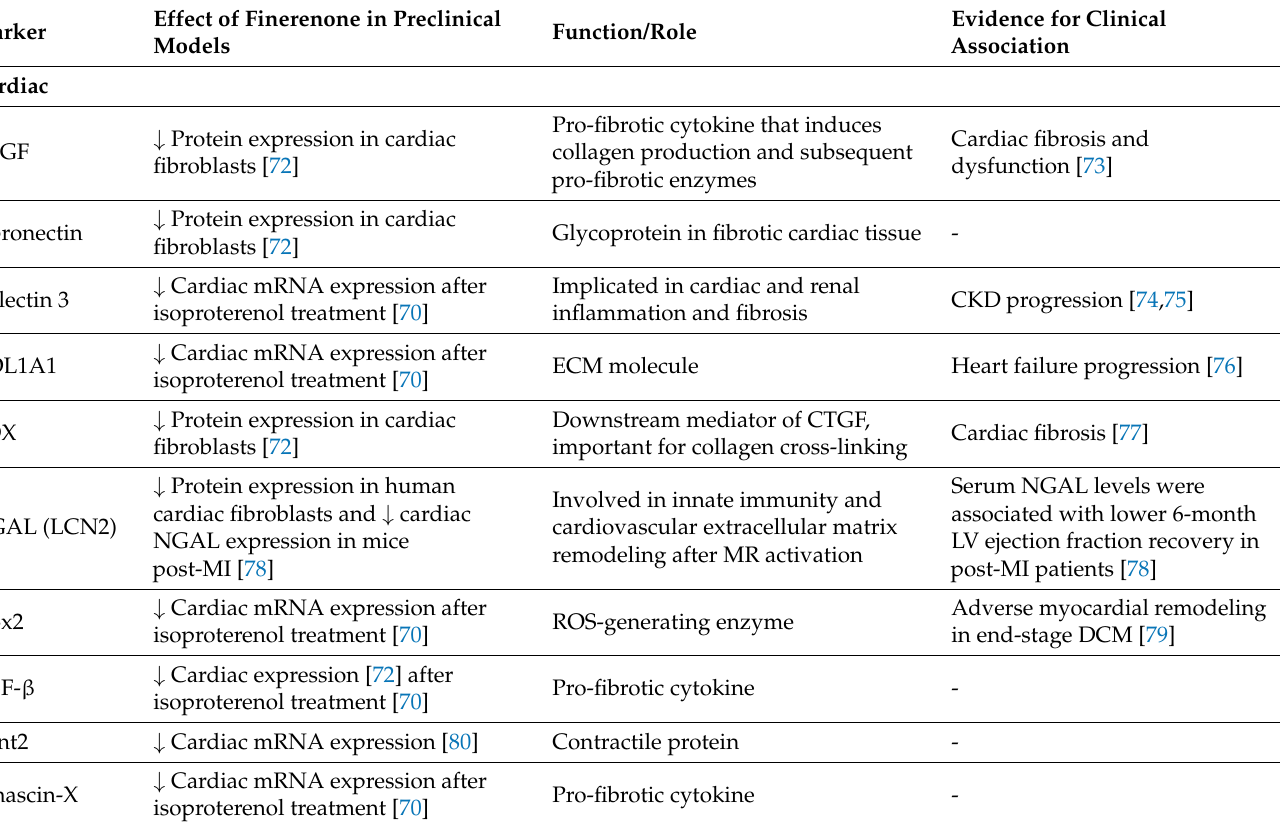
Table 2. Cardiac biomarkers modulated by finerenone in preclinical studies and their clinical